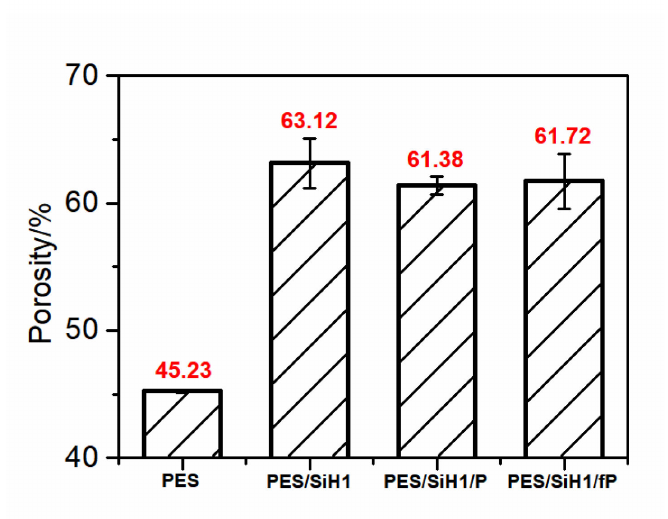
Figure 6. The porosity of the PES, PES/SiH1, PES/SiH1/P, and PES/SiH1/fP membranes.